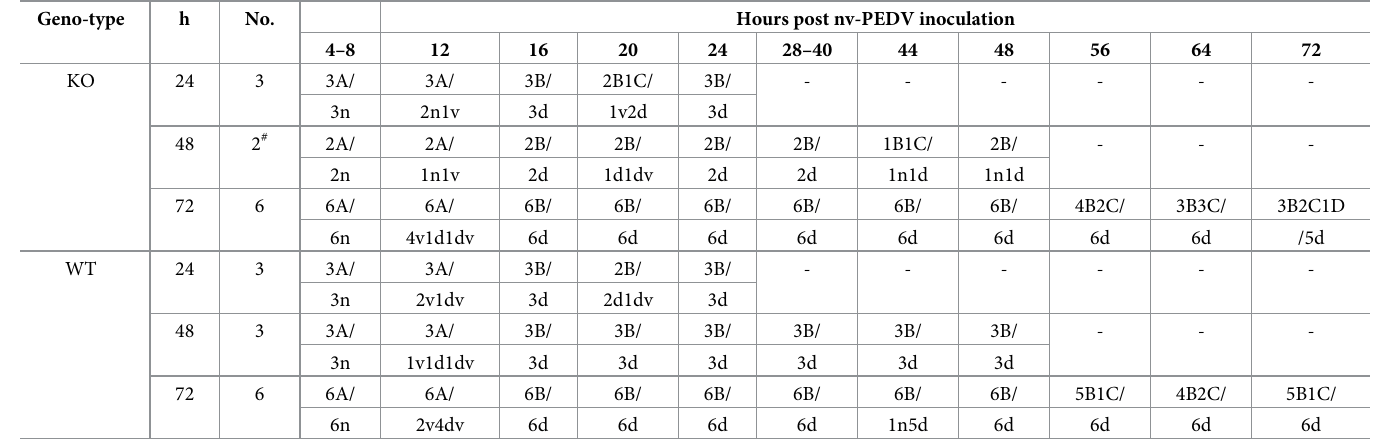
Note: No. of piglets with viability and clinical signs: viability—A is normal, B indicates decreased ability, C is moribund, and D is dead; clinical signs—n indicates no clinical signs, d is diarrhoea, and v is vomiting. # One piglet died before